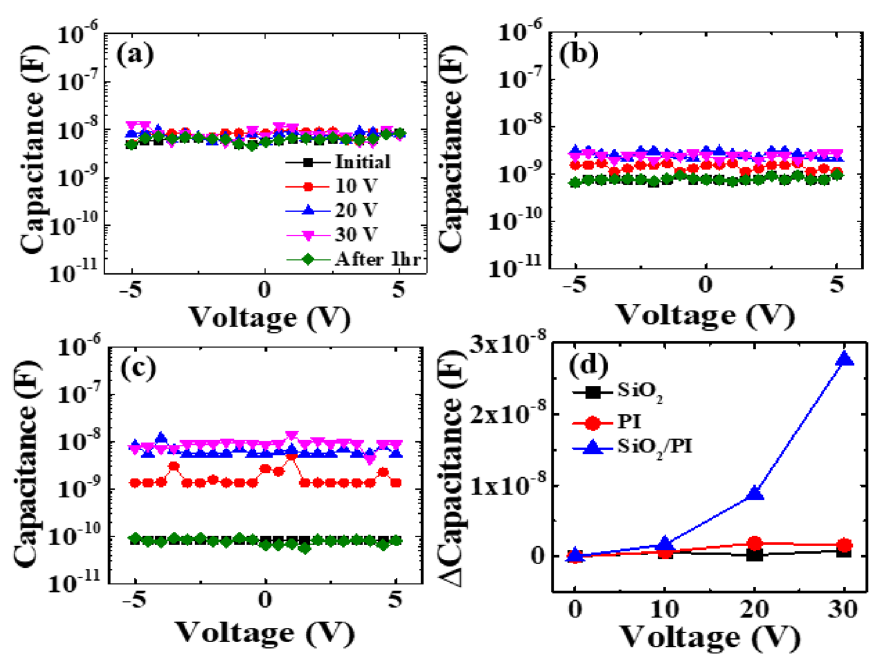
Figure 5. C–V characterization for 3 different MIM capacitors with increasing voltage; ( a ) Ag/SiO 2 /Ag, ( b ) Ag/ PI/Ag, ( c )